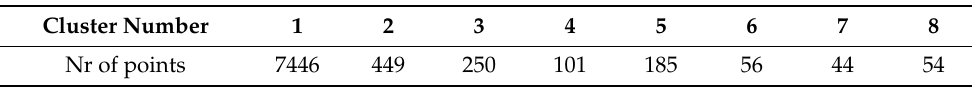
Table 1. Population in each